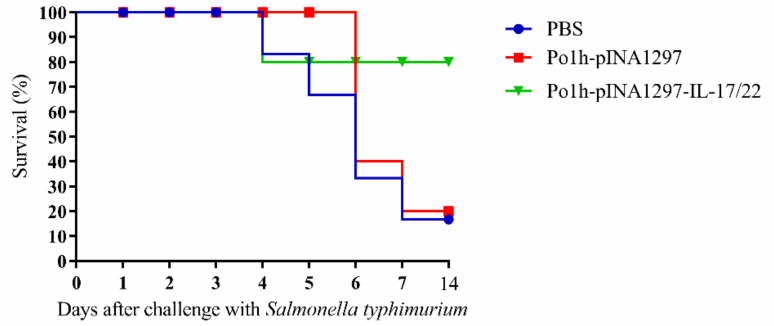
Figure 8. The survival percentage of mice after challenge.